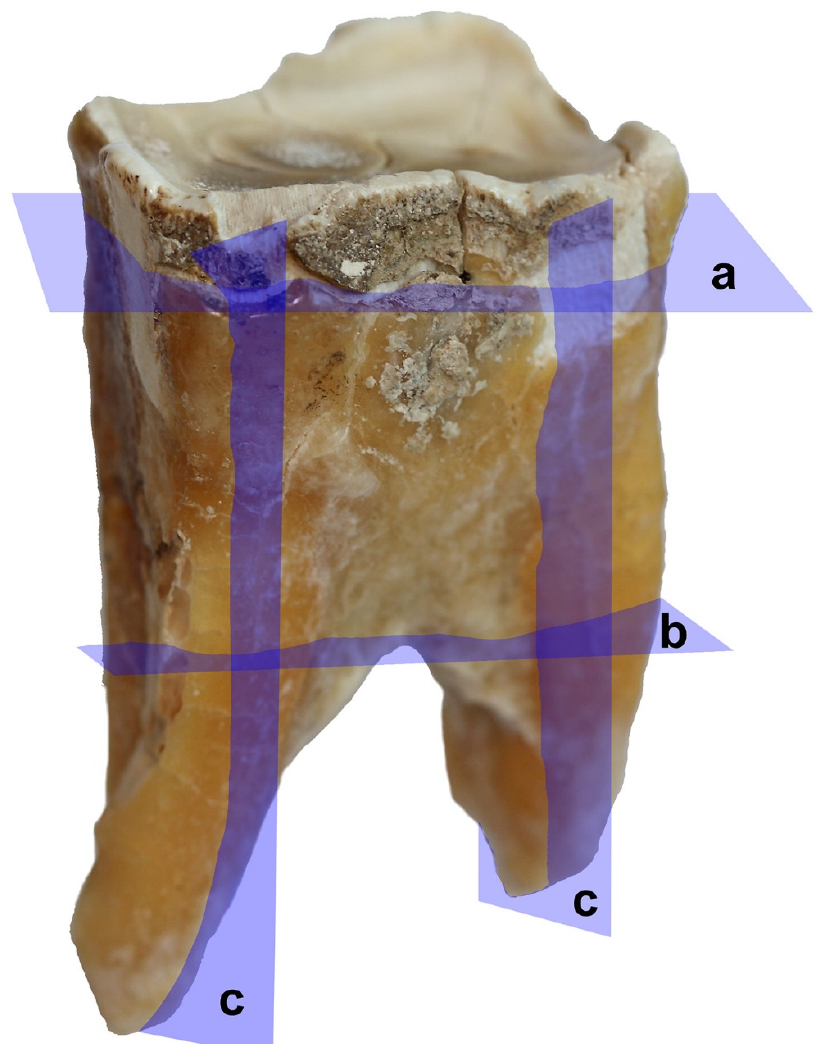
Figure 5. Cut sections on the third premolar (P 3 ) of the white rhinoceros female: a : horizontal section through the tooth crown; b : horizontal (axial, transverse) sections through the upper part of the root; c : longitudinal sections.